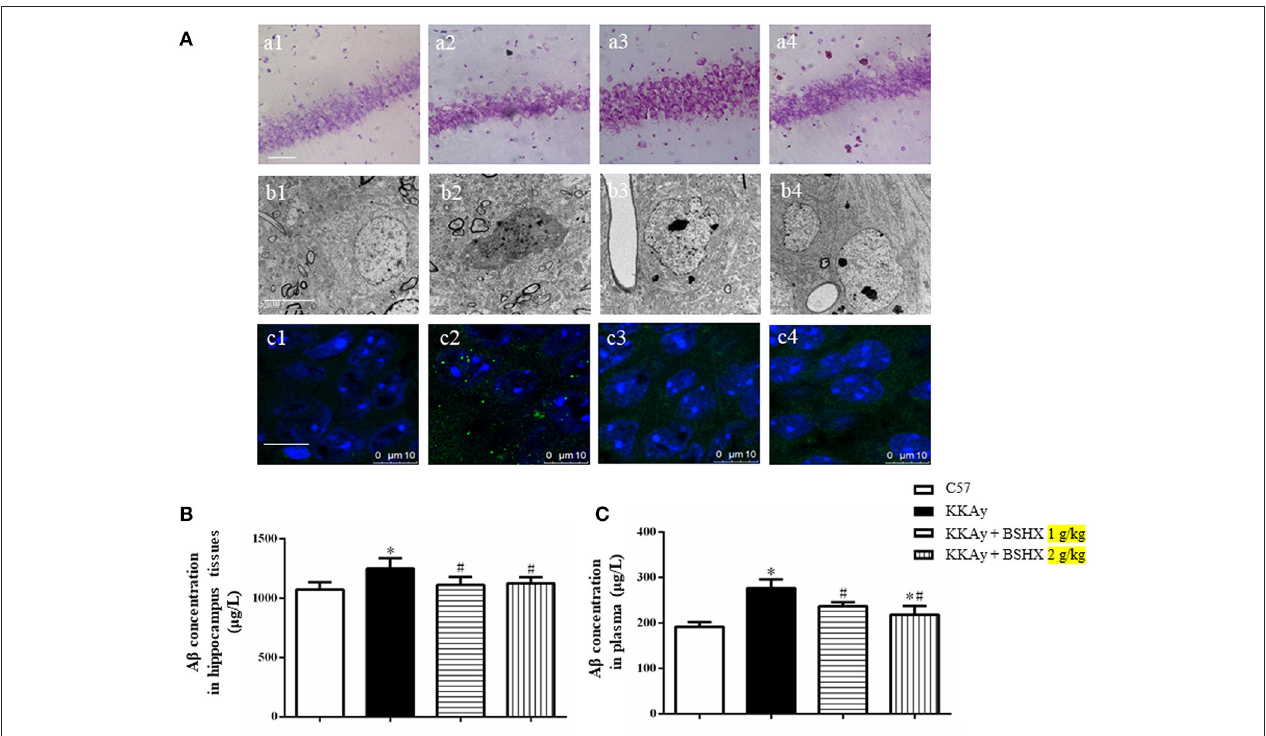
FIGURE 9 | The effect of BSHX on neurons damage in CA1 sector. (A) Representative Nissl staining (a), transmission electron micrographs of neurons (b) and immunofluorescence confocal images of A β (c) in the cerebral hippocampal CA1 of mice from different groups. 1: C57 group; 2: KKAy group; 3: KKAy + BSHX 1 g/kg group; 4: KKAy + BSHX 2 g/kg. (B) The effect of BSHX on the expression levels of A β in hippocampus tissues of mice. (C) The effect of BSHX on the expression levels of A β in plasma of mice. Data were expressed as mean ± SD ( n = 6). * p < 0.05 vs. C57 group, # p < 0.05 vs. KKAy